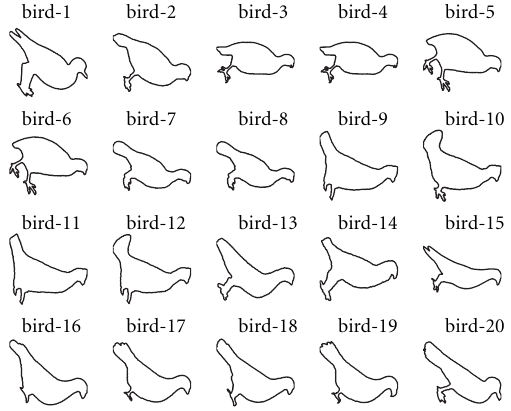
Figure 3: The contours in Figure 2 after